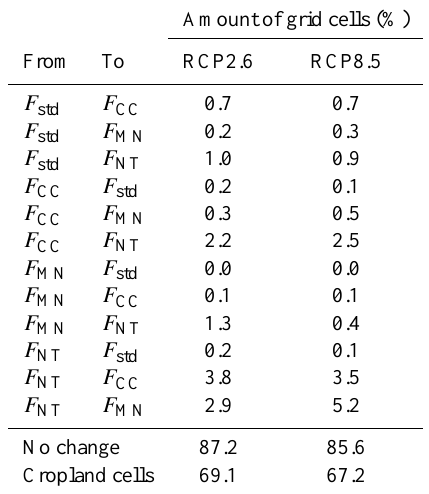
Table 5. The relative (%) number of cropland grid cells with a shift regarding the management practice optimal from a carbon seques- tration perspective, comparing the highest SOC for 1996–2005 and for 2046–2055 for RCP2.6 and 8.5. Also listed are the share of the cropland grid cells with no change in the optimal C sequestration practice and the percentage of the total number of grid cells that were cropland around the year 2000 in the data set from Hurtt et al. (2011). See Table 2 for